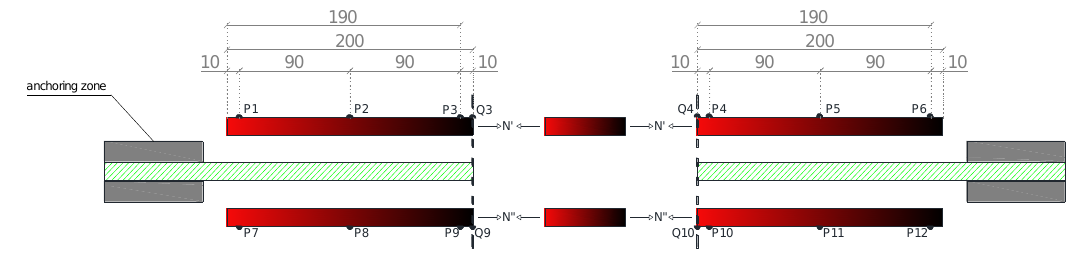
Figure 17. Load versus elongation graph—joint sample “II”.